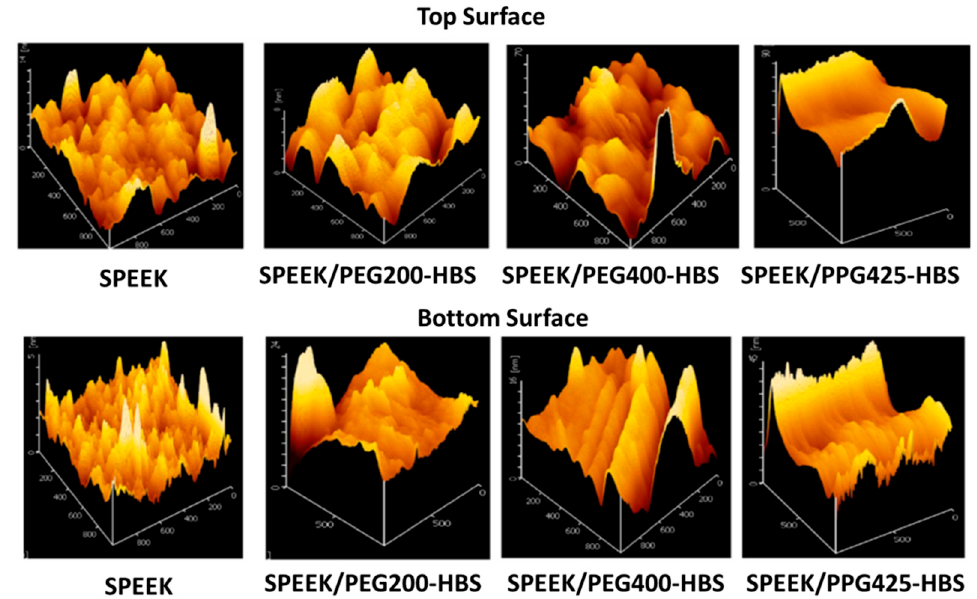
Figure 11. AFM image of nodule structure on membrane surfaces. Reproduced with permission from [96]. Copyright Elsevier,